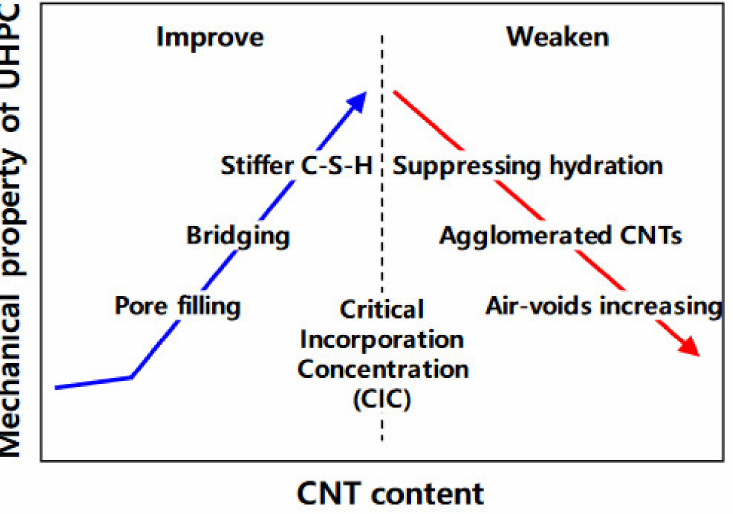
Figure 8. The effects of CNTs on the mechanical properties of ultrahigh-performance concrete (UHPC). Reproduced from Ref